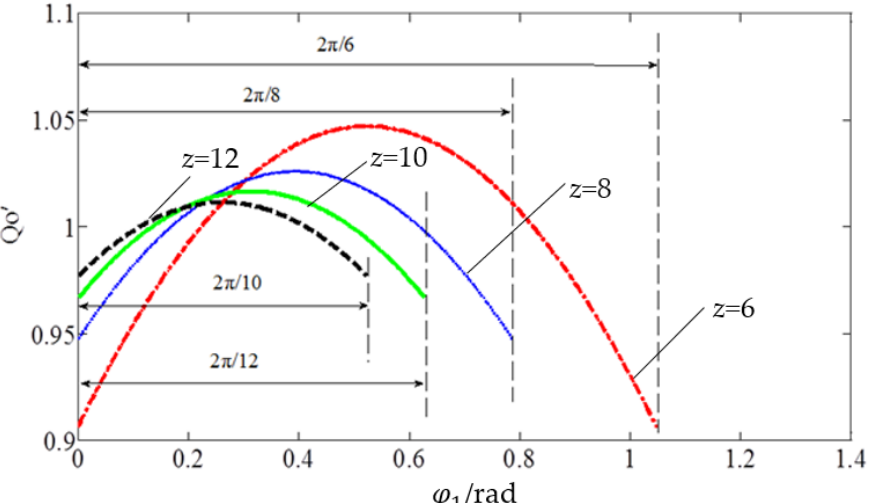
Figure 3. Output flow pulsation curve of piston pump with even number of pistons ( z = 6, 8, 10, 12) .